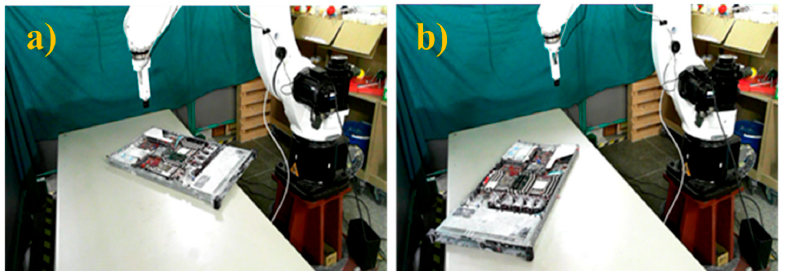
Figure 15. Two different object positions after random manual displacement and rotation to test the object correction system. ( a ) The first and ( b ) second random positions of the object.